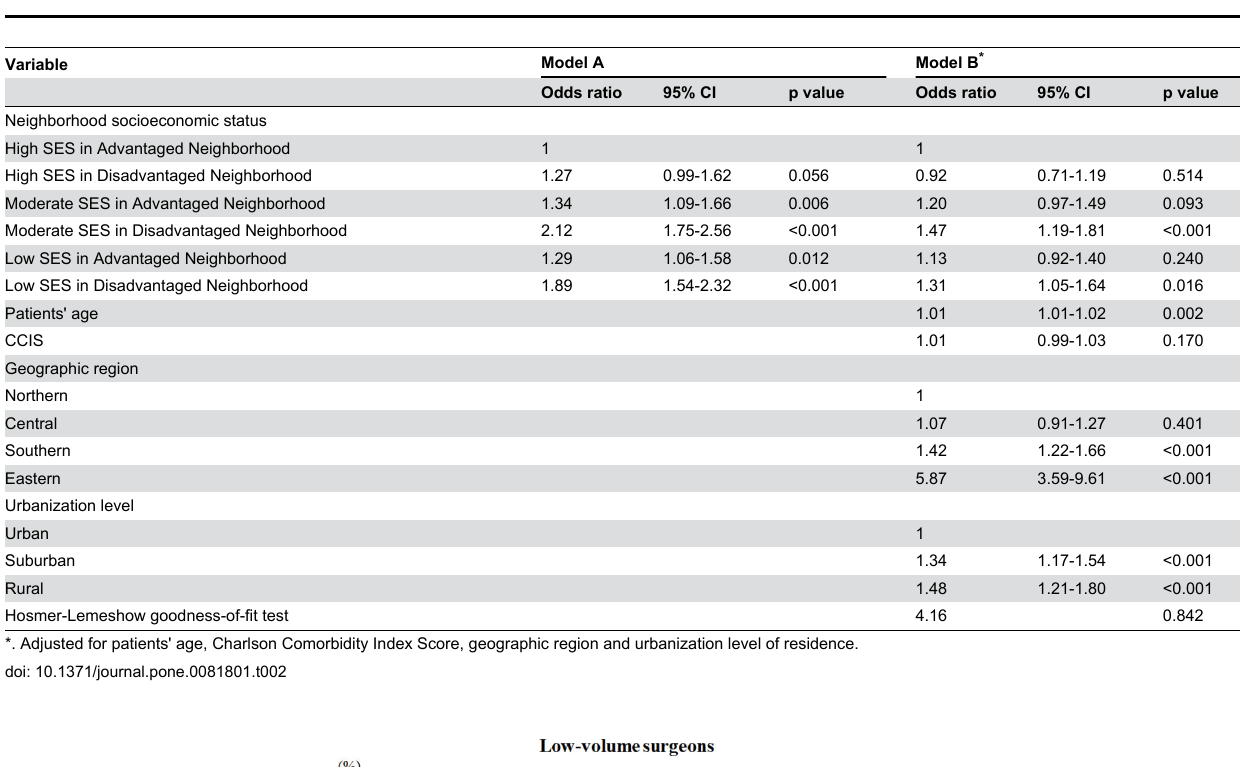
Table 2. Odds ratios of individual SES for low-volume hospital in advantaged and disadvantaged neighborhoods.